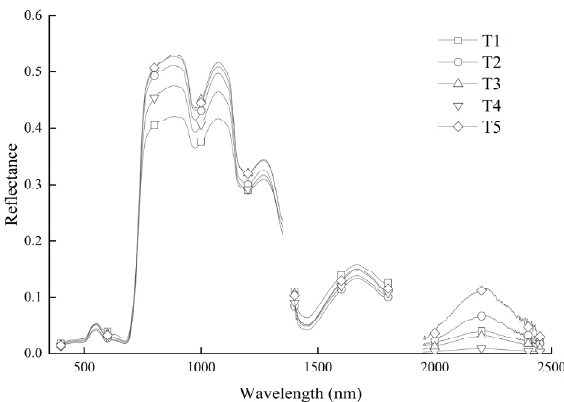
Figure 2. Change rule of winter wheat canopy spectrum under different treatments. Note: Take the flowering stage in the 2021 experiment as an example.